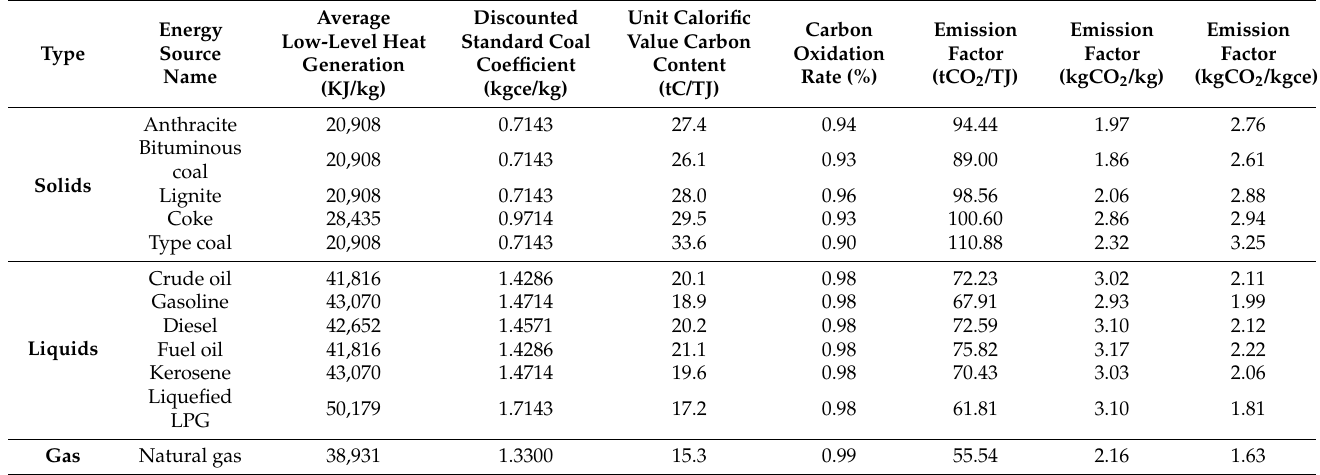
Table 2. Summary of CO 2 emission factors for various fossil fuels.